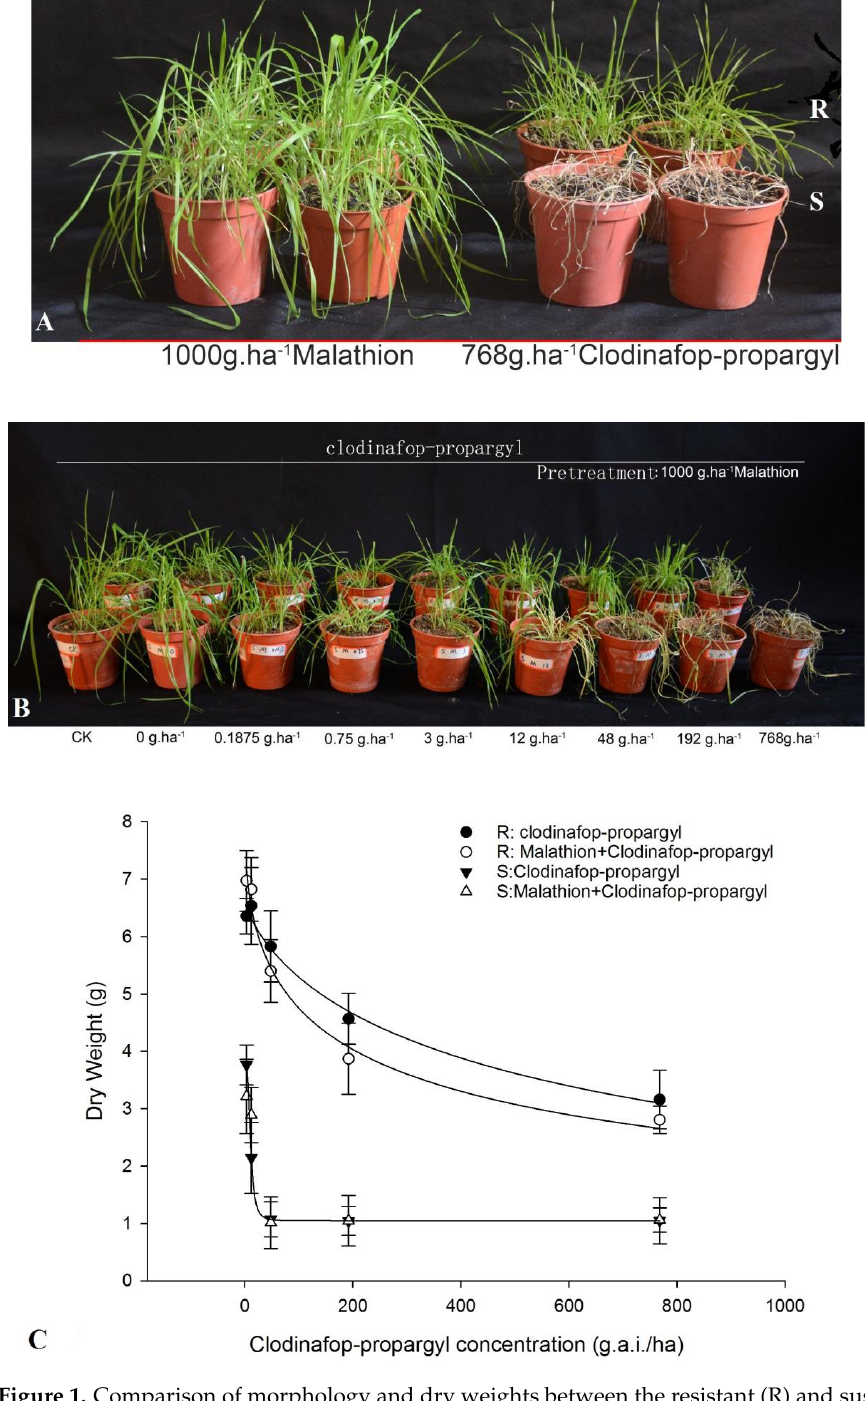
Figure 1. Comparison of morphology and dry weights between the resistant (R) and susceptible (S) populations of P. fugax . ( A ) Morphology comparison of R and S P. fugax populations after application of malathion or clodinafop − propargyl alone. ( B ) Morphology comparison of R and S P. fugax after application of different concentrations of clodinafop − propargyl after Malathion pretreatment. ( C ) The dry weights comparison of R and S P. fugax populations after different